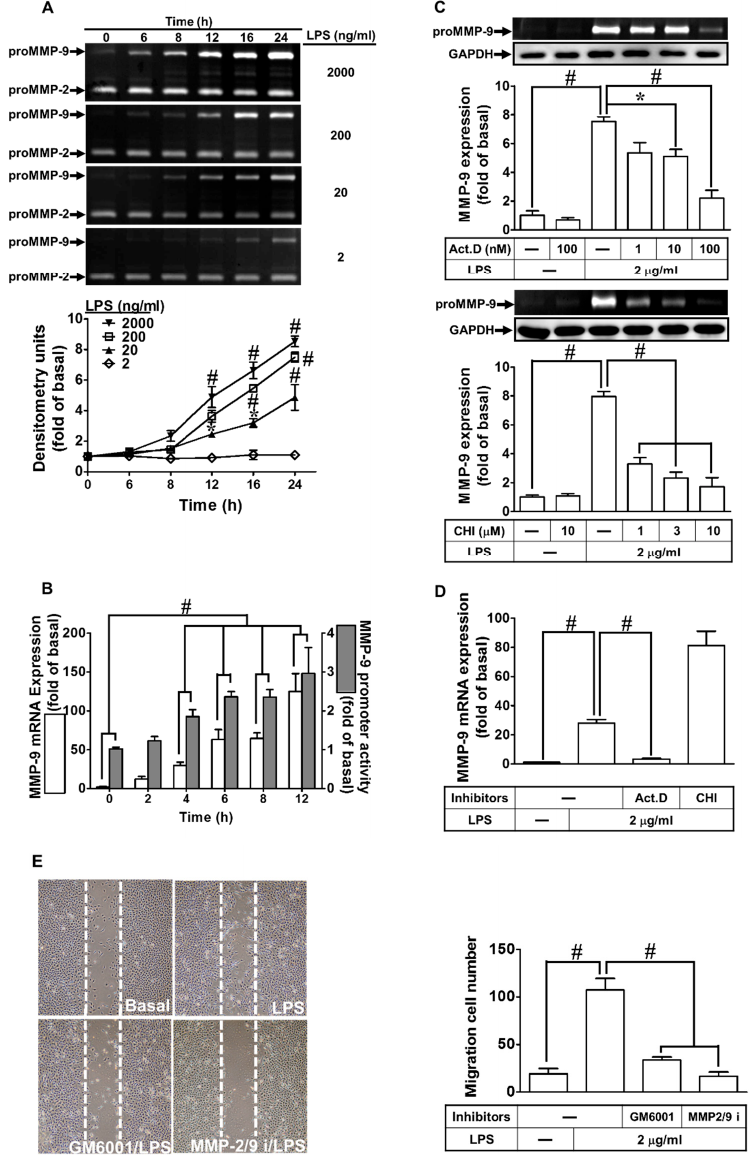
Figure 1. Lipopolysaccharide (LPS) induced metalloproteinase-9 (MMP-9) expression and cell migration in rat brain astrocytes (RBA-1) cells. ( A ) Cells were incubated with various concentrations of LPS (2, 0.2, 0.02, and 0.002 µ g / mL) for the indicated time intervals (0, 6, 8, 12, 16, and 24 h). The levels of